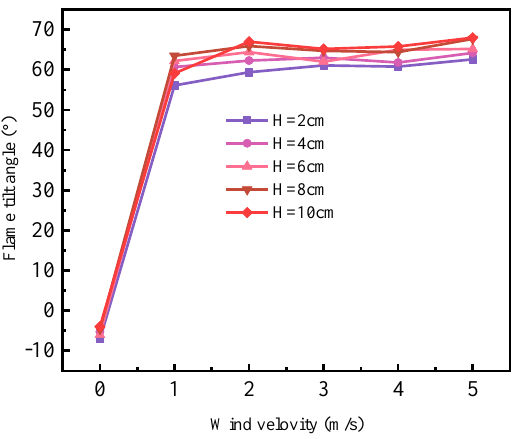
Figure 10. Flame tilt angles α of pool fires at varying baffle heights and crosswind velocities.